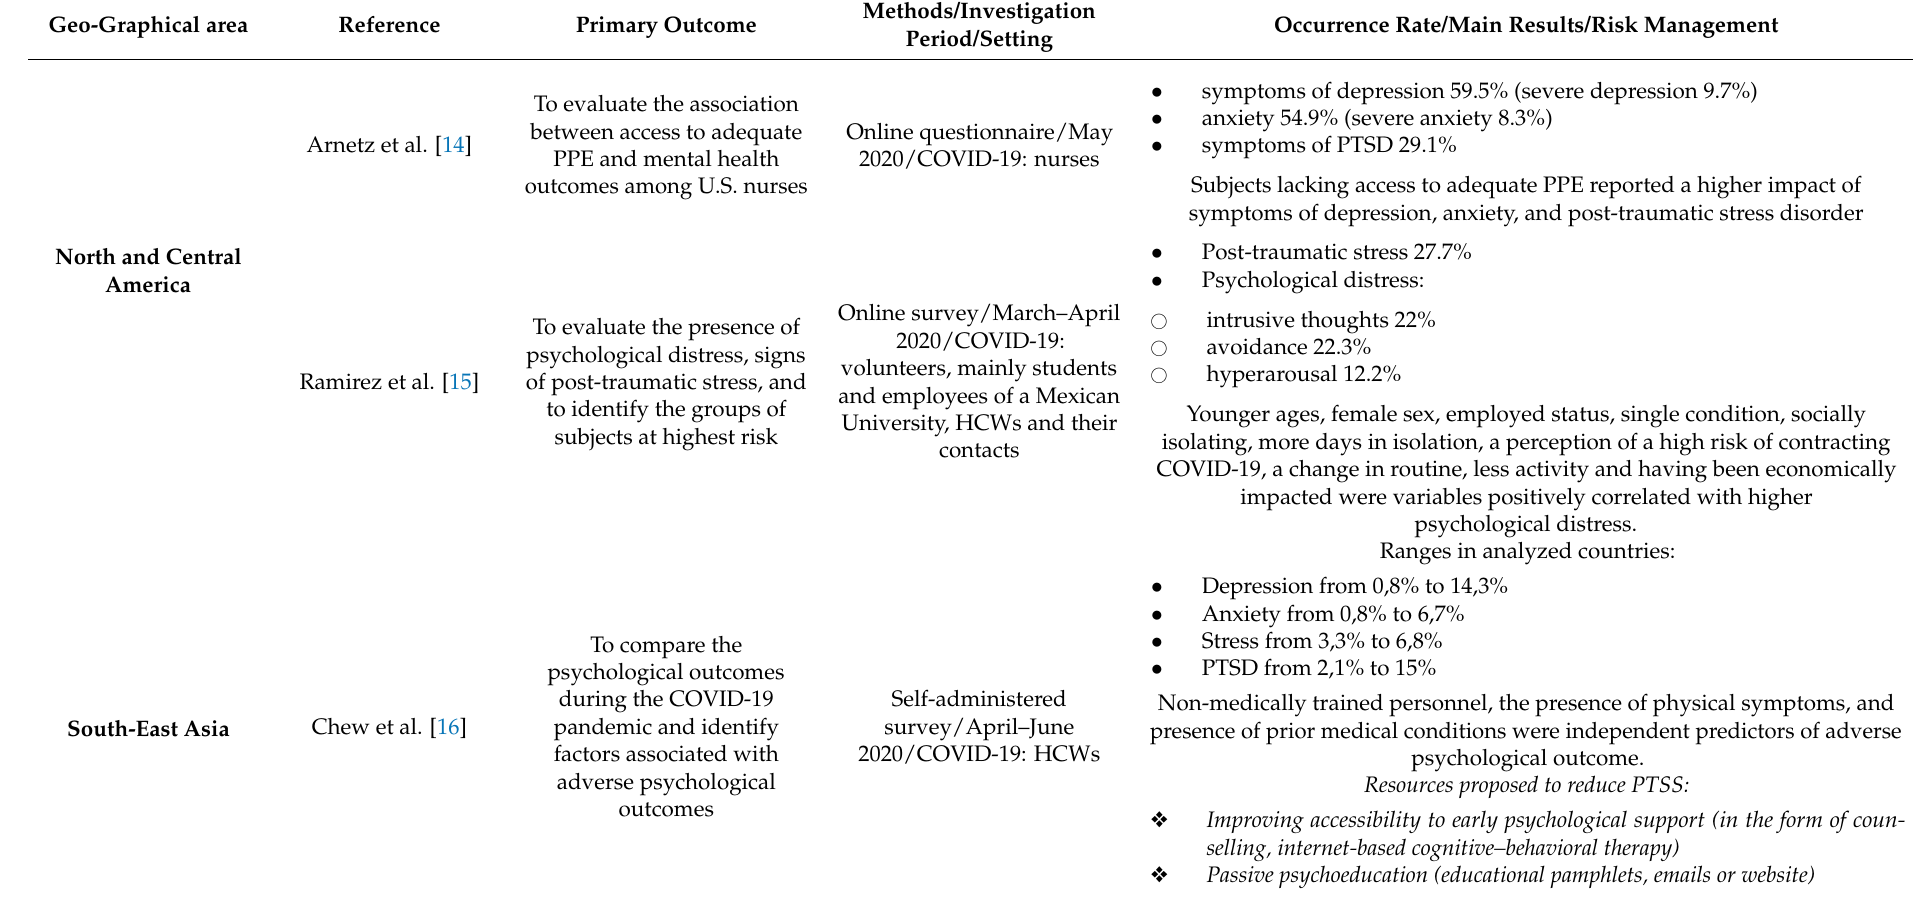
Table 2. Characteristics, outcomes, and main results of the studies included in the